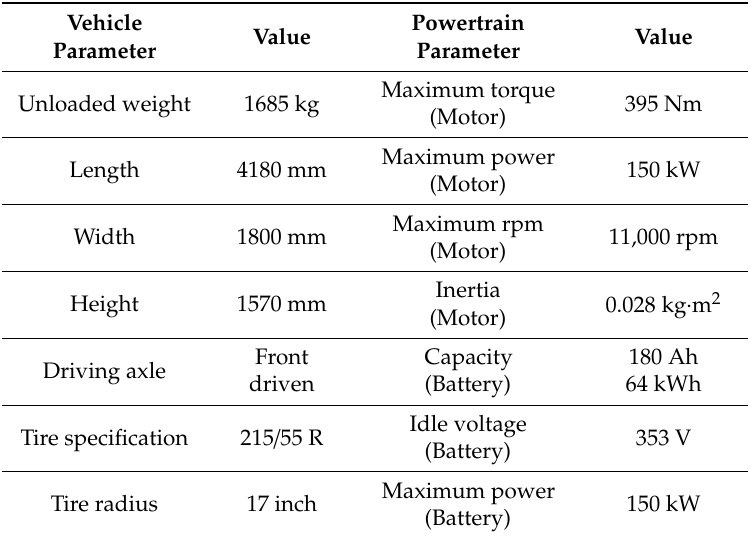
Table 2. Specification of the target vehicle (Hyundai KONA